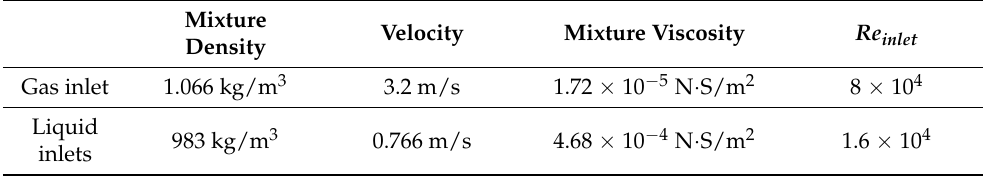
Table 2. This table highlights the important parameters of inlet flow of Case 1 ( L / G =4.9) for the small-scale